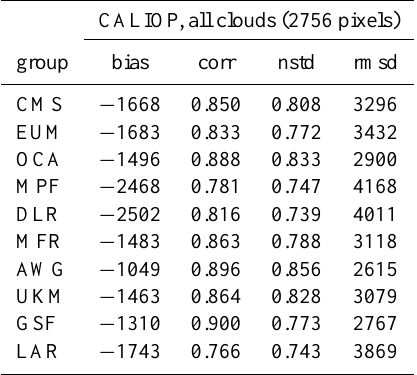
Table 6. Comparison with CALIOP for 13 June 2008, 12:00– 15:30UTC. The table shows the difference of SEVIRI minus CALIOP of the mean CTH (bias), correlation between SEVIRI and CALIOP data set (corr), standard deviation of the single data sets divided by that of CALIOP (normalized standard deviation, nstd) and the root mean square difference (rmsd) between the SEVIRI data sets and CALIOP. Pixels are taken into account, for which all SEVIRI algorithms as well as the CALIOP retrieval provide CTH values. Bias and rmsd are given in meter. CALIOP derives a mean CTH of 7852m with a standard deviation of